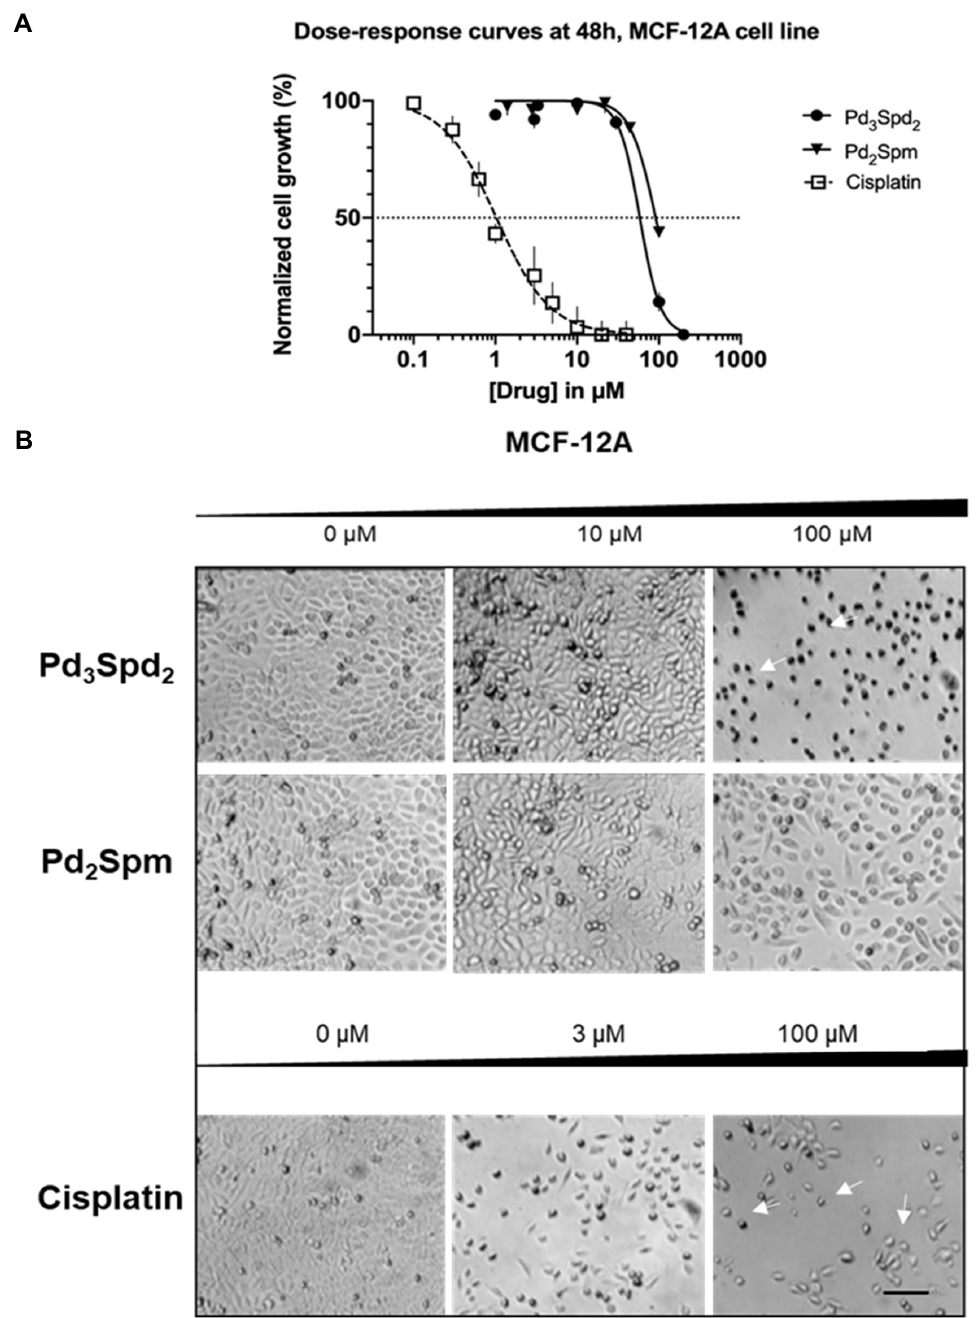
Figure 6. Impact of increasing concentrations of Pd 3 Spd 2 , Pd 2 Spm or cisplatin on breast healthy cells (MCF-12A) incubated with the drug for 48 h. ( A ) Dose–response curves for cell proliferation. Values are expressed as the mean ± SEM from 4 independent experiments (in triplicate) analyzed with nonlinear regression and the Student’s t -test. Data points with no visible error bars have errors smaller than the size of the symbol. ( B ) Representative photomicrographs showing morphological changes. White arrows show cytoplasmic shrinkage and the rounding of cells. Representative images from 4 independent experiments obtained under an objective lens of a phase contrast of the LionheartFX microscope. Scale bar = 100 µ